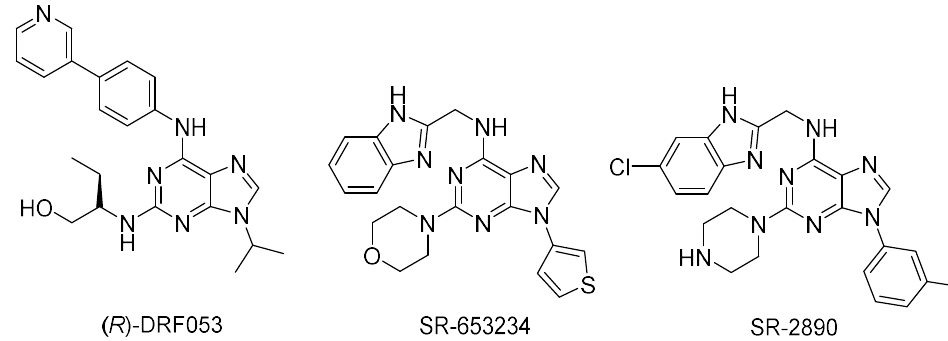
Figure 1. Structures of adenine-based CK1 δ inhibitors.